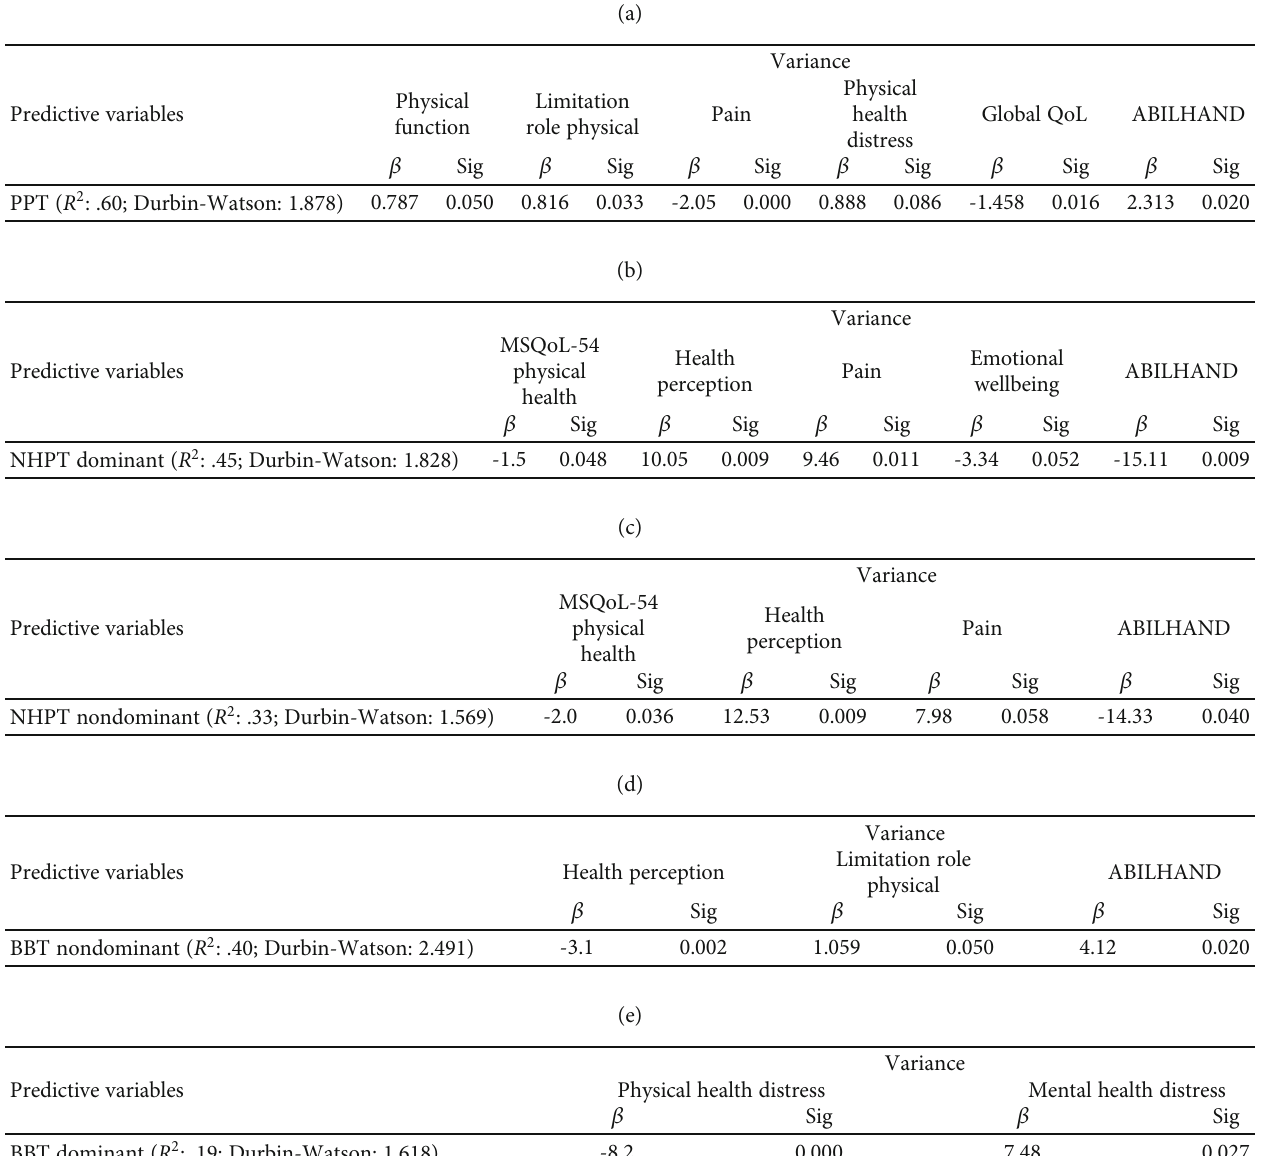
Table 3: Variance predictors in quality of life tools ( n = 30